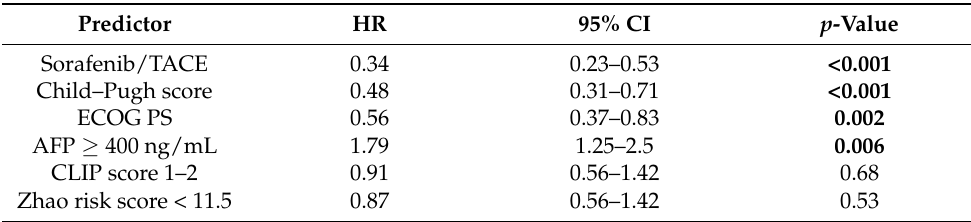
Table 4. Multivariate analysis of predictors for